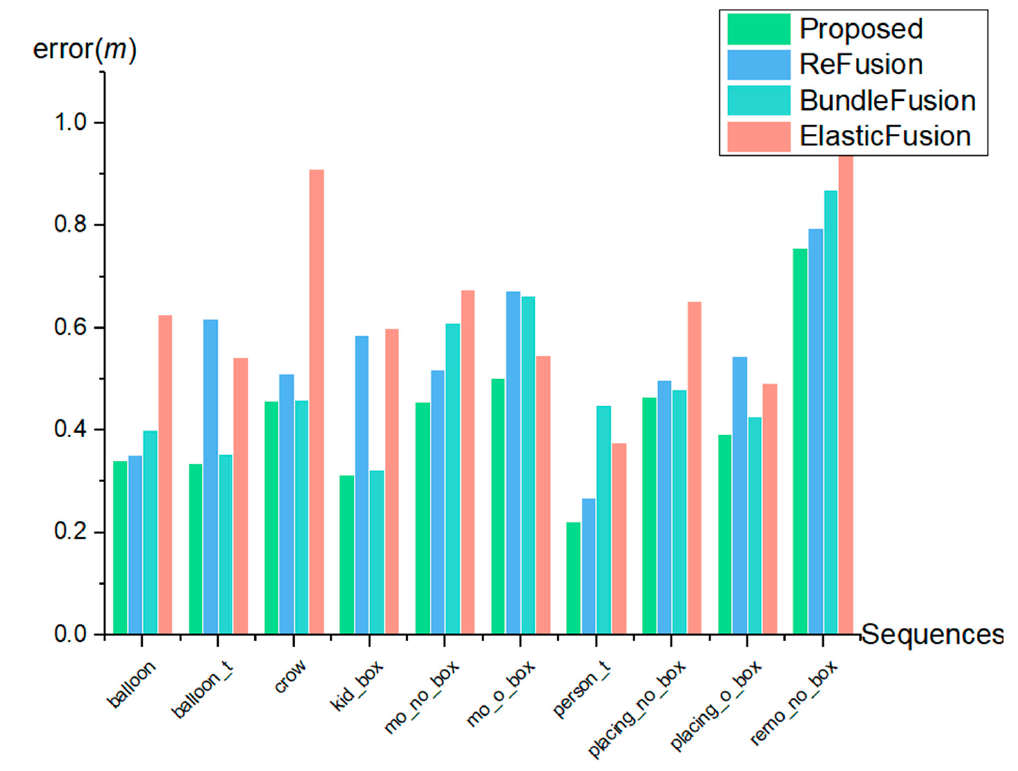
Figure 9. Surface reconstruction error (m).